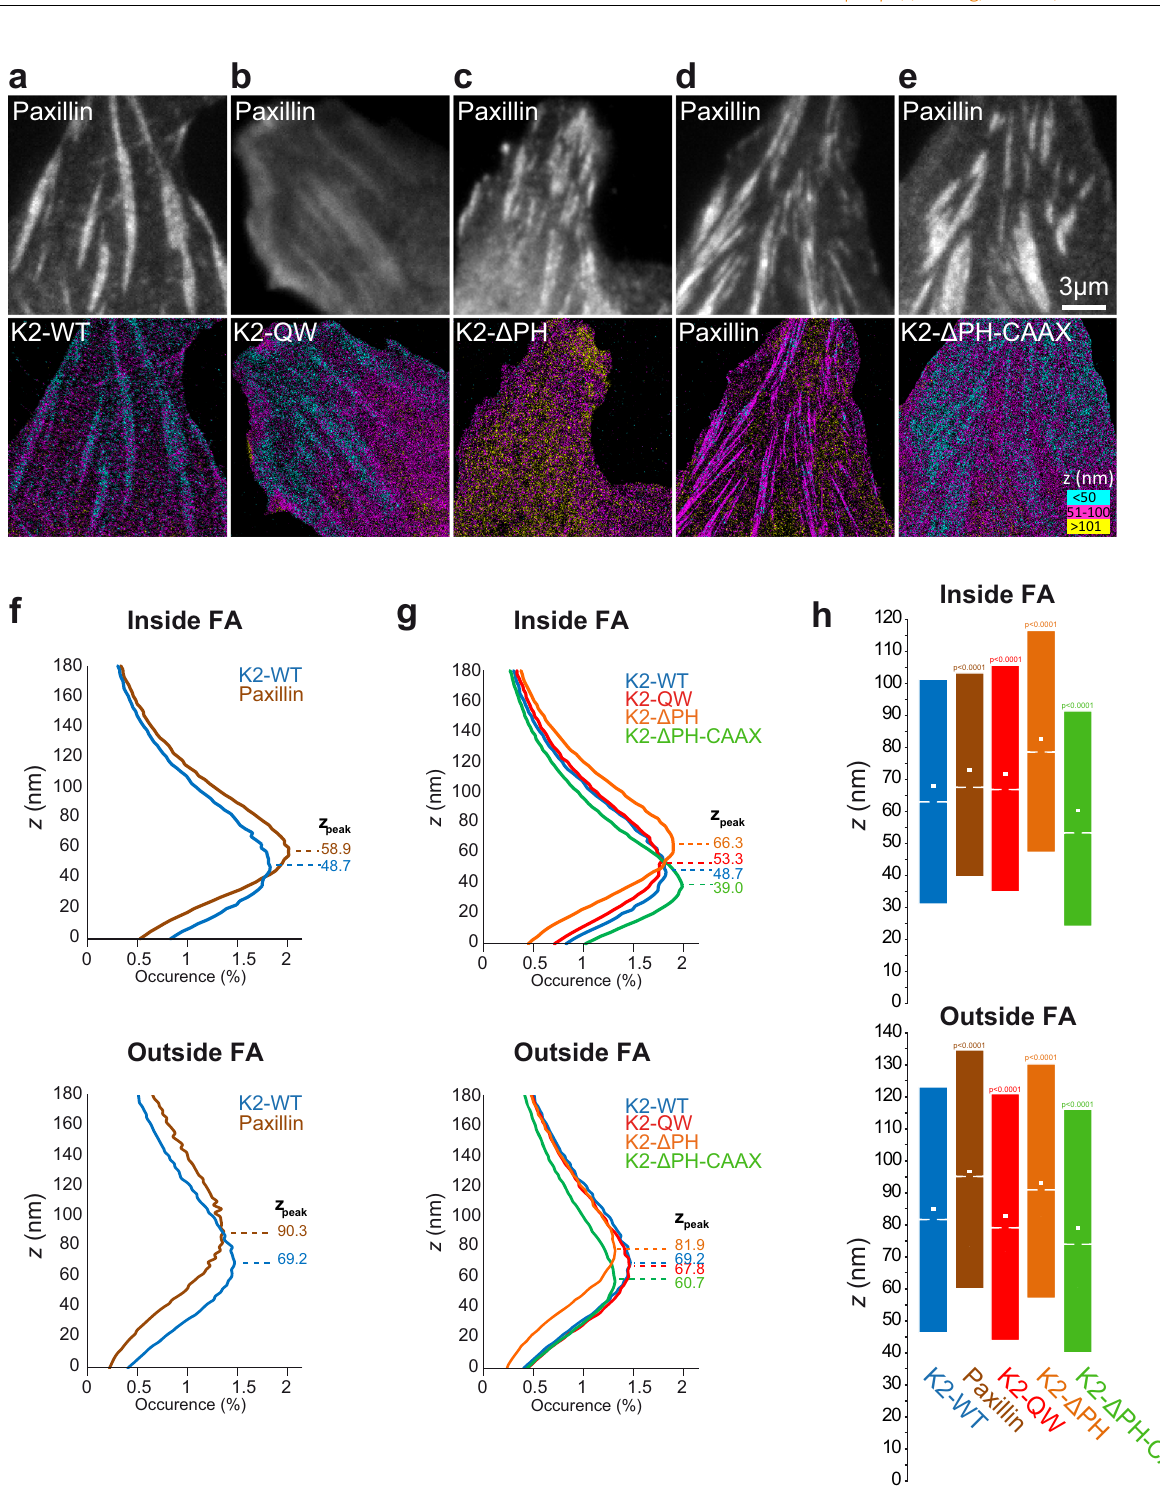
anti-GFP nanobodies labeled with AlexaFluor-647 49 . Like demon- strated previously 4 , N-terminus labeled GFP-paxillin were